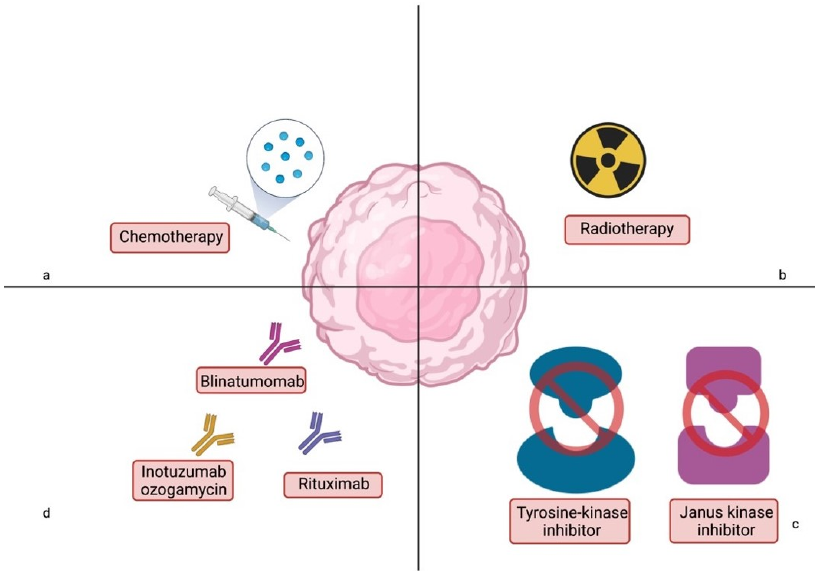
Figure 1. Current therapeutic options for acute lymphoblastic leukemia in children. Starting with conventional therapies: ( a )—chemotherapy and ( b )—radiotherapy; through targeted treatment via kinase inhibitors—( c ); ending with the latest treatment methods—( d ). Image created with biorender.com (accessed on 14 March 2022).